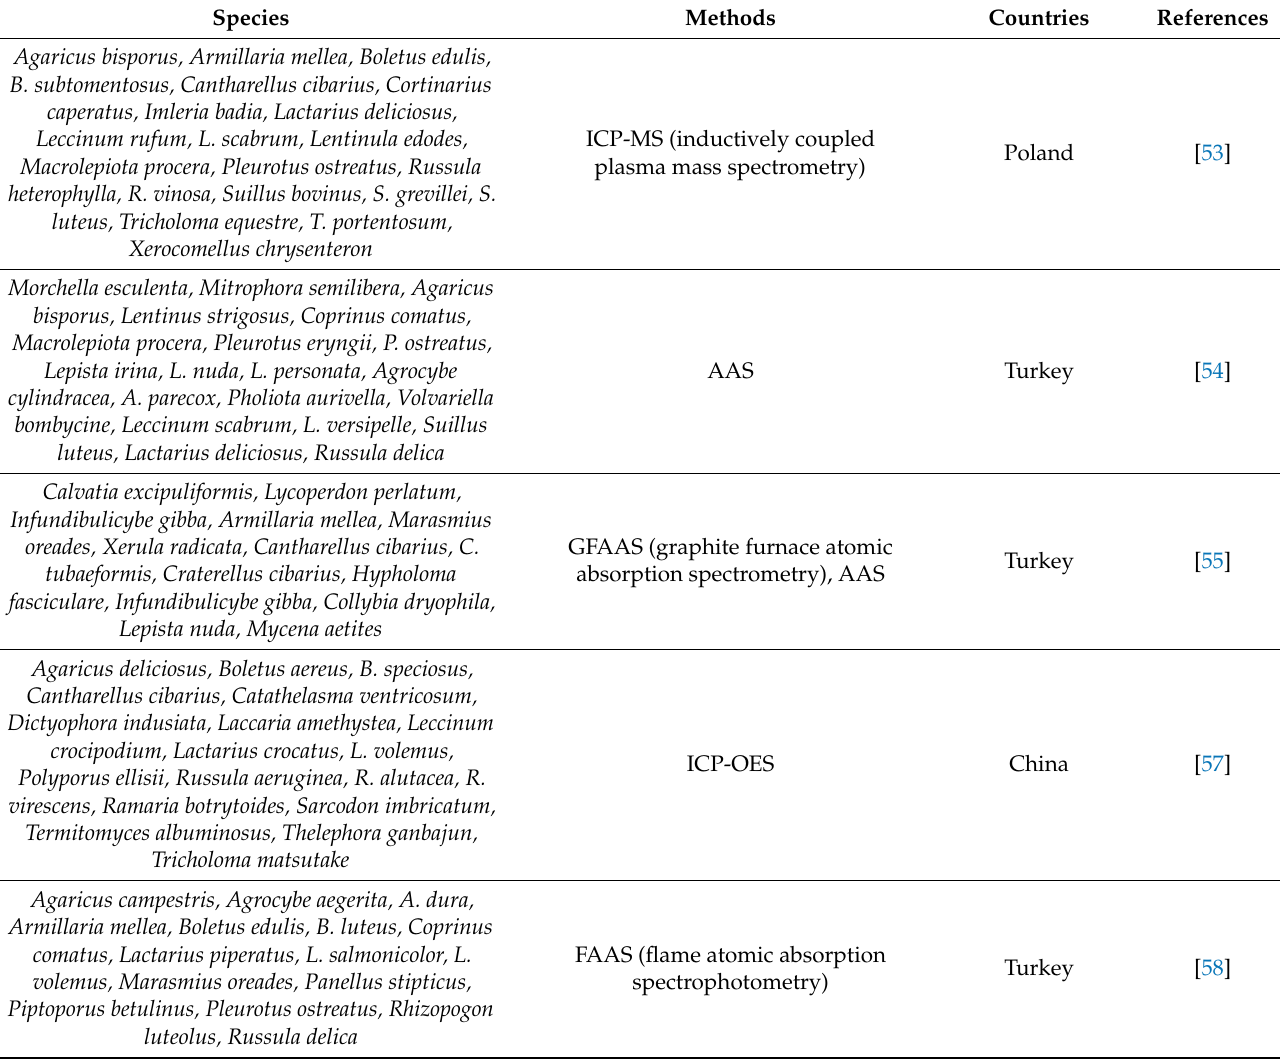
Table 3. Species, methods for determination of copper, and countries in the